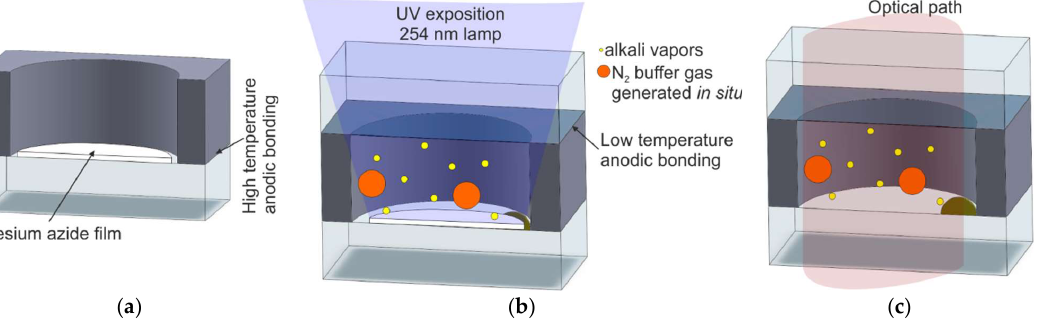
Figure 8. Process steps for obtaining cesium vapor cell using alkali azide deposition and ultraviolet (UV) photolysis: ( a ) silicon–glass preform with deposited alkali azide film, ( b ) UV exposition toward chemical reaction, ( c ) cross section of the cell.